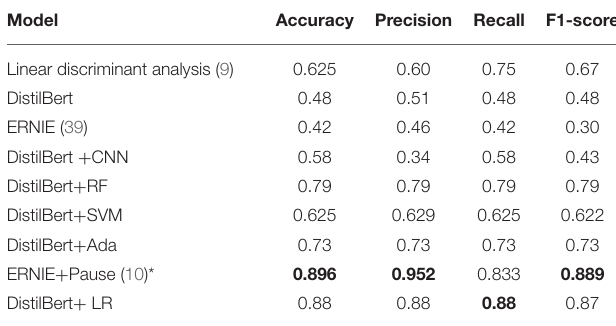
TABLE 5 | The performance of different